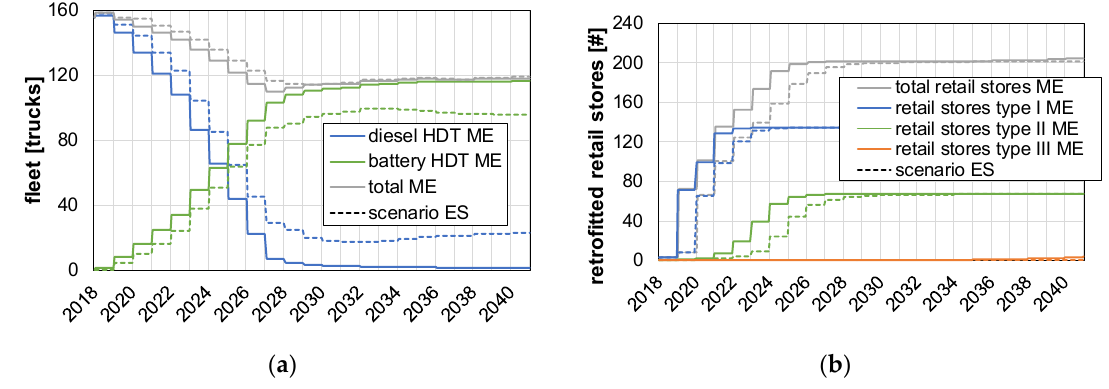
Figure 8. Diffusion of battery-electric HDTs in the LSP’s fleet over time in two different scenarios ( a ) and development of demand for nighttime delivery over time ( b ).